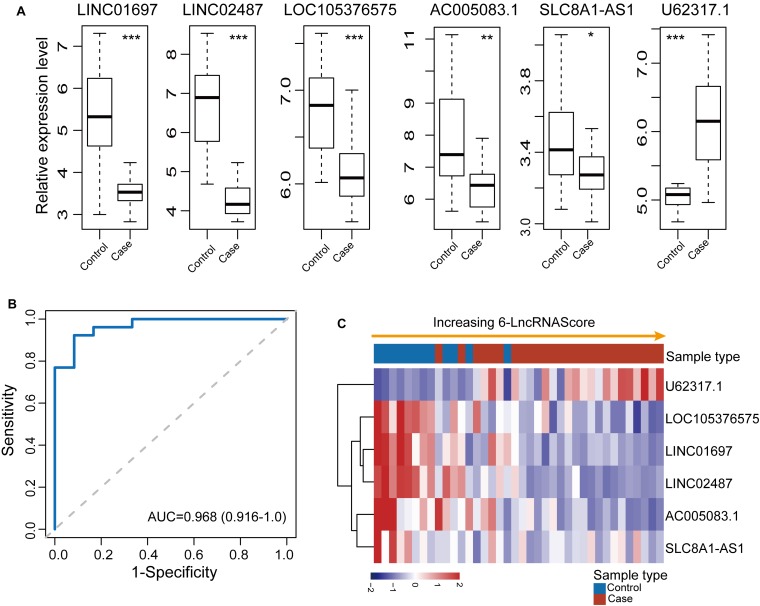
Independent validation of the 6lncRNAScore in 38 samples of GSE9844. (A) Expression patterns of six lncRNA biomarkers between OSCC samples and control samples. (B) Receiver operating characteristic (ROC) curves for 6lncRNAScore. (C) Expression heatmap of six lncRNA biomarkers of samples with increasing 6lncRNAScore. *p < 0.05, **p < 0.01, ***p < 0.001.